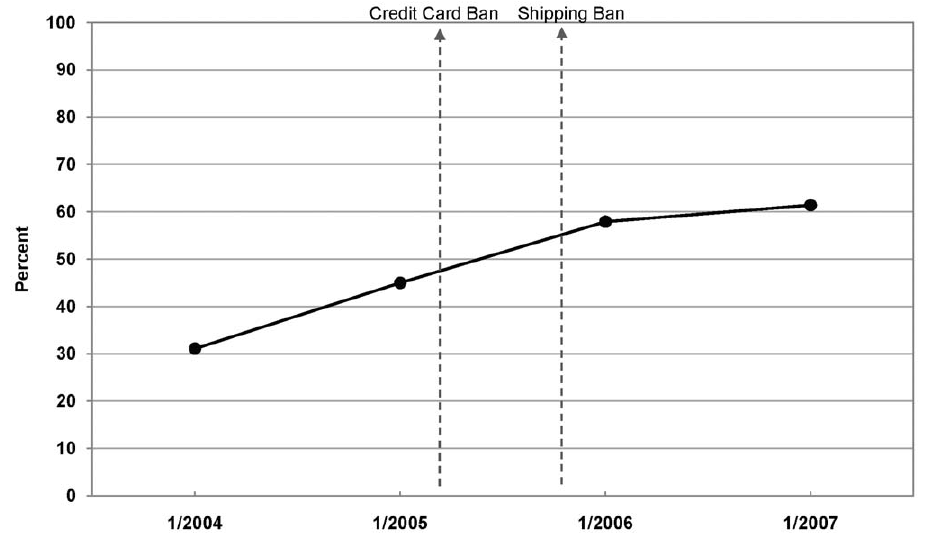
Figure 1. Internet cigarette vendor attrition over time, 2004–2007. Proportion of vendors identified a year earlier whose websites were no longer in operation (1/2006 values represent attrition of sites identified 1/2005, before the bans were implemented).